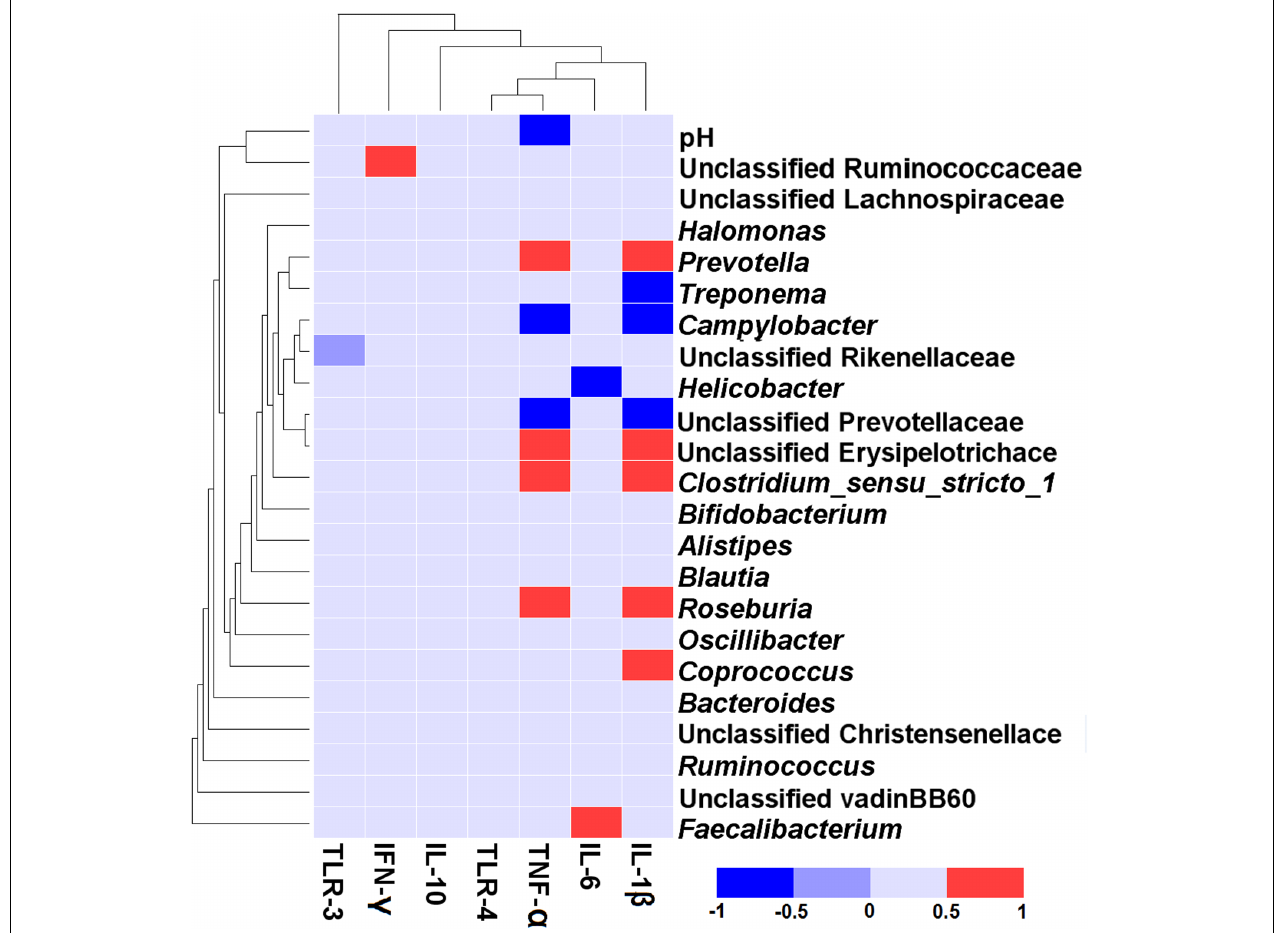
FIGURE 5 | Correlation analysis between the abundance of taxa (at genus level), colonic pH, and the colonic inflammatory cytokine expression. Only the predominant genera (those with a relative abundance ≥ 1% in at least one treatment) in the colonic mucosa are shown. Cells are colored based on Spearman correlation coefficient. The red color represents a significant positive correlation ( P < 0.05), the blue color represents a significant negative correlation ( P < 0.05), and the light blue shows that the correlation was not significant ( P >